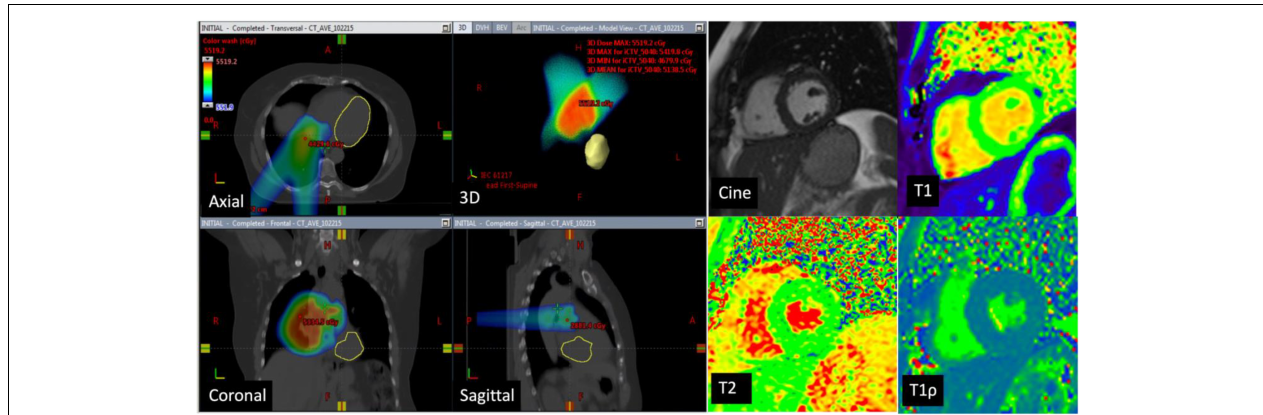
FIGURE 2 | CT images in a 73-year-old man with lung cancer—Axial, coronal, sagittal, and 3D CT images with color-washed dose distribution. The heart is depicted in yellow and is not in the planned radiation field. The patient received a total of 50.4 Gy of which the mean dose to the left ventricle was 0.02 Gy. Cardiac magnetic resonance (CMR) images at baseline with normal LVEF (65%), normal native T1 mapping (1,043 ms), normal T2 mapping (47 ms), and elevated T1 ρ at 78 ms. Follow-up CMR in 6 months showed no significant difference in native T1 and T2 values and the T1 ρ values remained elevated.